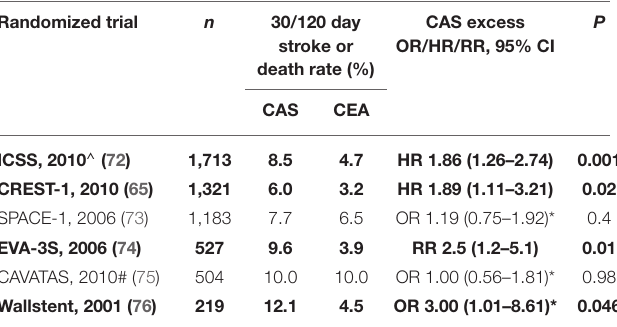
TABLE 3 | Peri-procedural rate of stroke or death with CAS compared to CEA in the largest randomized trials of symptomatic patients. Randomized